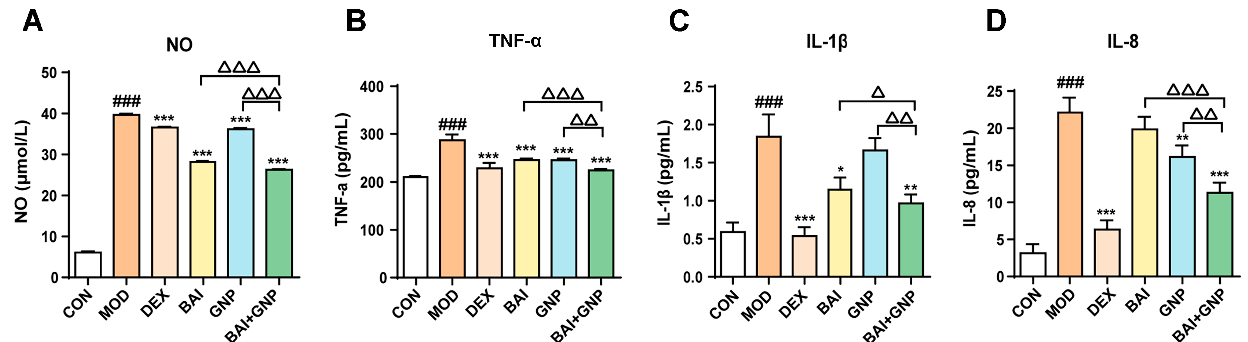
Figure 4. Lipopolysaccharide-induced synergistic inhibition of NO ( A ), TNF- α ( B ), IL-1 β ( C ), and IL-8 ( D ) productions by BAI and GNP ( n = 6). Each bar represents the mean ± SD. ### p < 0.001 vs. control group; * p < 0.05, ** p < 0.01, and *** p < 0.001 vs. model group; △ p < 0.05, △△ p < 0.01, and △△△ p < 0.001 vs. combination group. BAI, baicalein; CON, control; DEX, dexamethasone; GNP, genipin; MOD, model; NO, nitric oxide; IL-1 β , interleukin 1 β ; IL-8, interleukin 8; TNF- α , tumor necrosis factor- α .